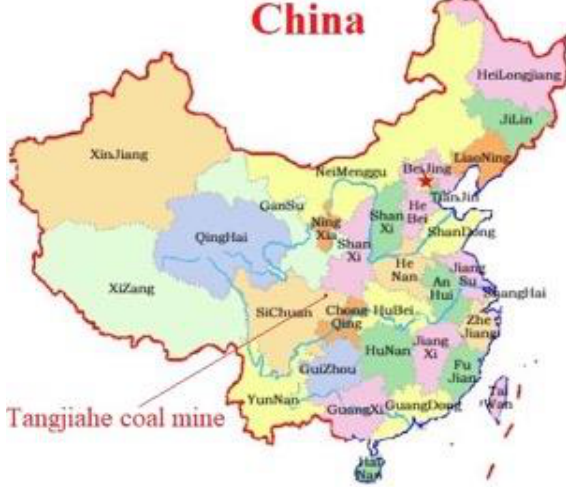
Figure 1. Location of the Tangjiahe coal mine.